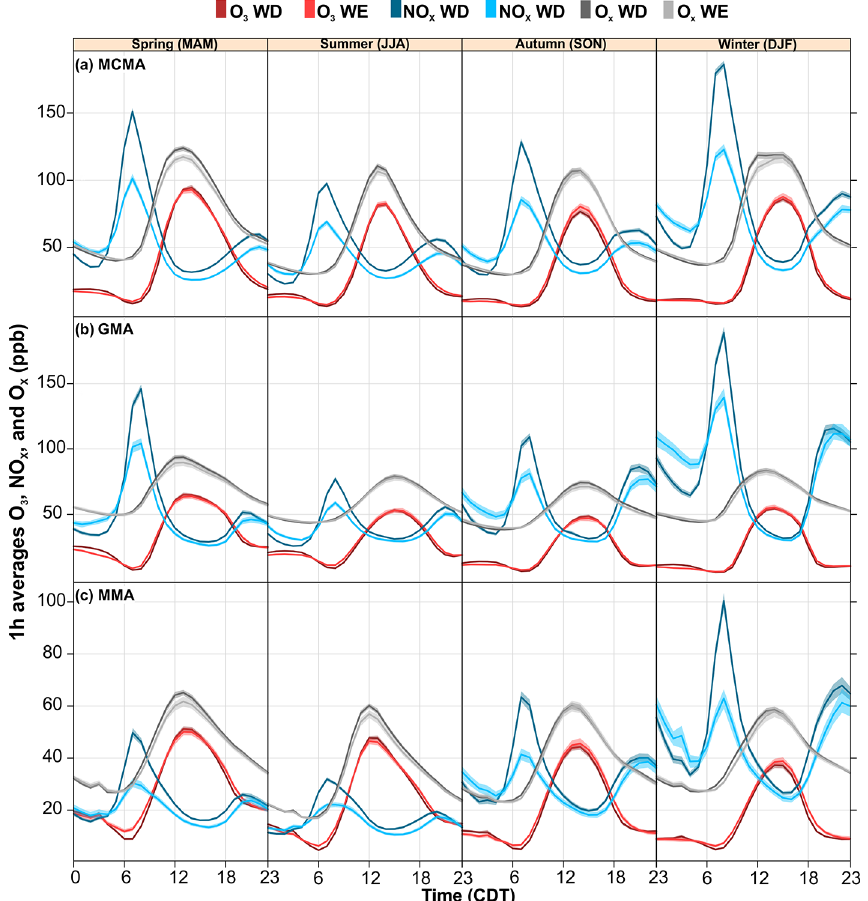
Figure 8. Seasonal average diurnal cycles of O 3 , O x , and NO x during 1993–2014 for the MCMA and the MMA, and between 1996 and 2014 for the GMA. The shading shows the 95% confidence intervals of the average, calculated through bootstrap resampling (Carslaw, 2015).